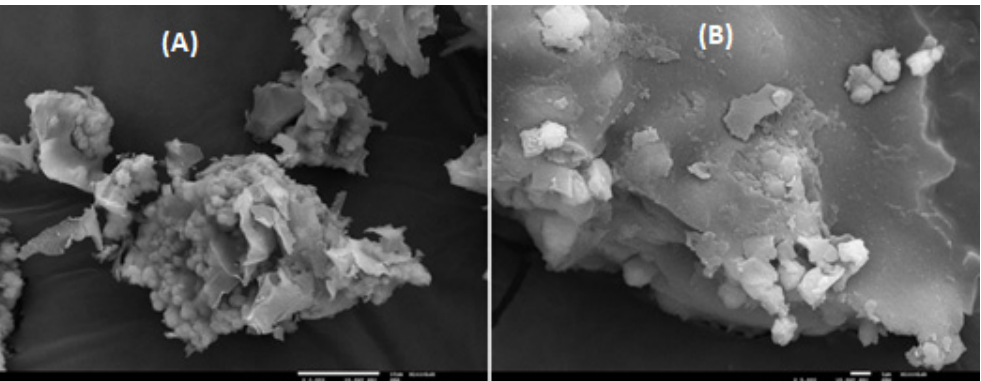
Figure 11. SEM images of z. HY catalyst sample collected after the methanation reaction process, at 300 °C and with 4% (w/w) of z. HY catalyst ( A : 2000 x, 10  m; B : 5000 x, 1  m).